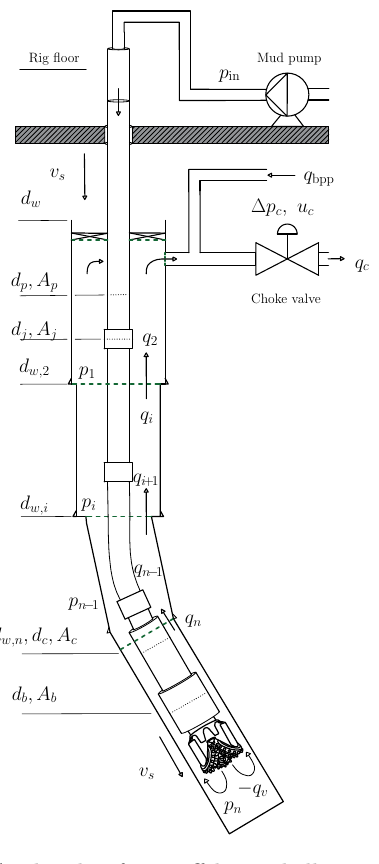
Figure 1: A sketch of an offshore drilling operation. The variable v s denotes the tripping speed. Green dashed lines mark the boundary of each segment in the